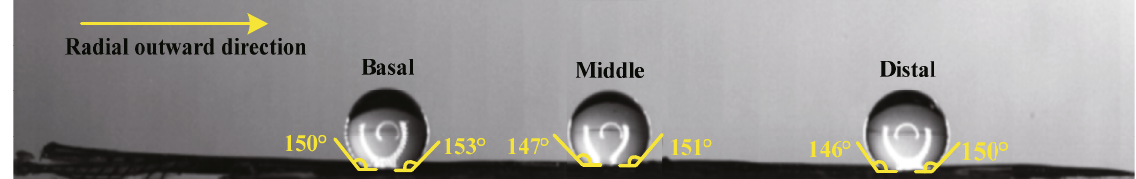
Fig. 3 Static contact angles of 3 µL drop at different positions on dragonfly wing